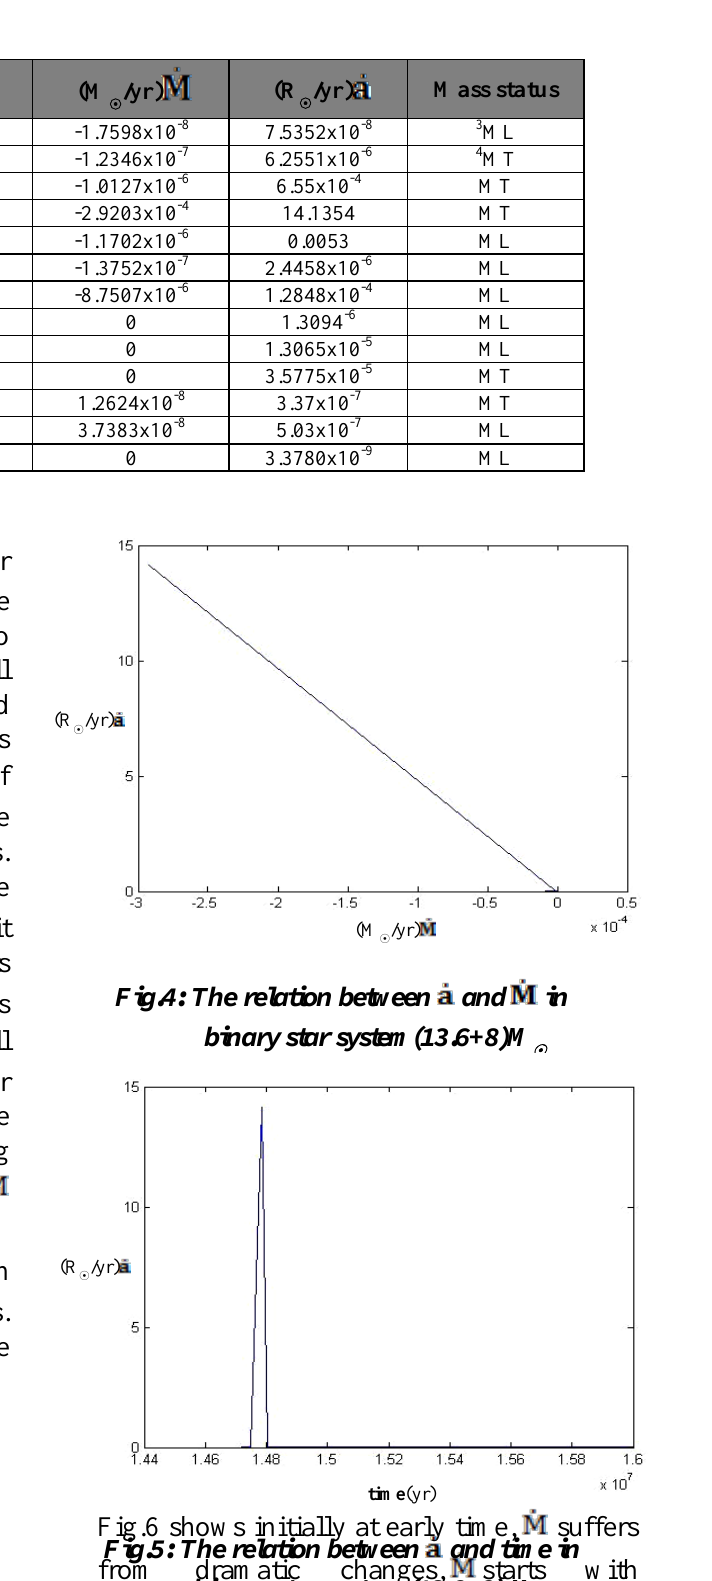
Fig.5: The relation between and time in binary star system (13.6+8) M